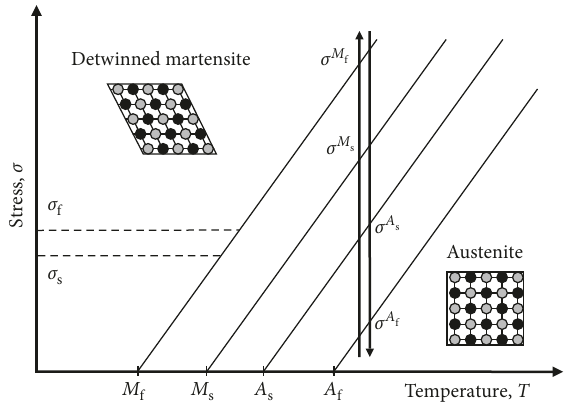
Figure 1: A superelastic loading path (from Lagoudas [6]).